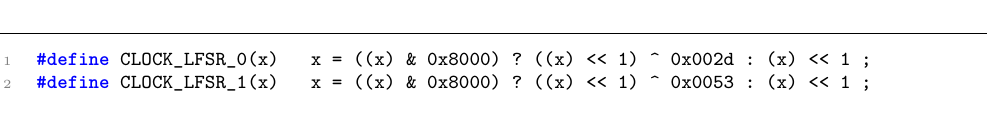
Figure 15: Clocking the LFSRs used to derive the round